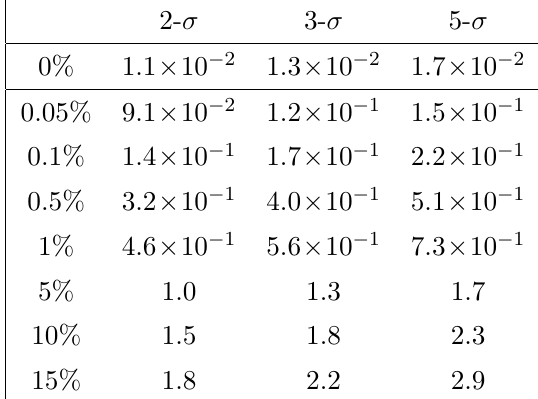
Table 2 . Upper limits on the parameter C ˜ /f a ( TeV − 1 ) achieved by considering 0 . 05% , 0 . 1% , G 0 . 5% , 1% , 5% , 10% and 15% relative systematic uncertainties on the number of total background events for the benchmark case with m a = 500 GeV. The first row represents the limits achieved without any systematic uncertainties on the